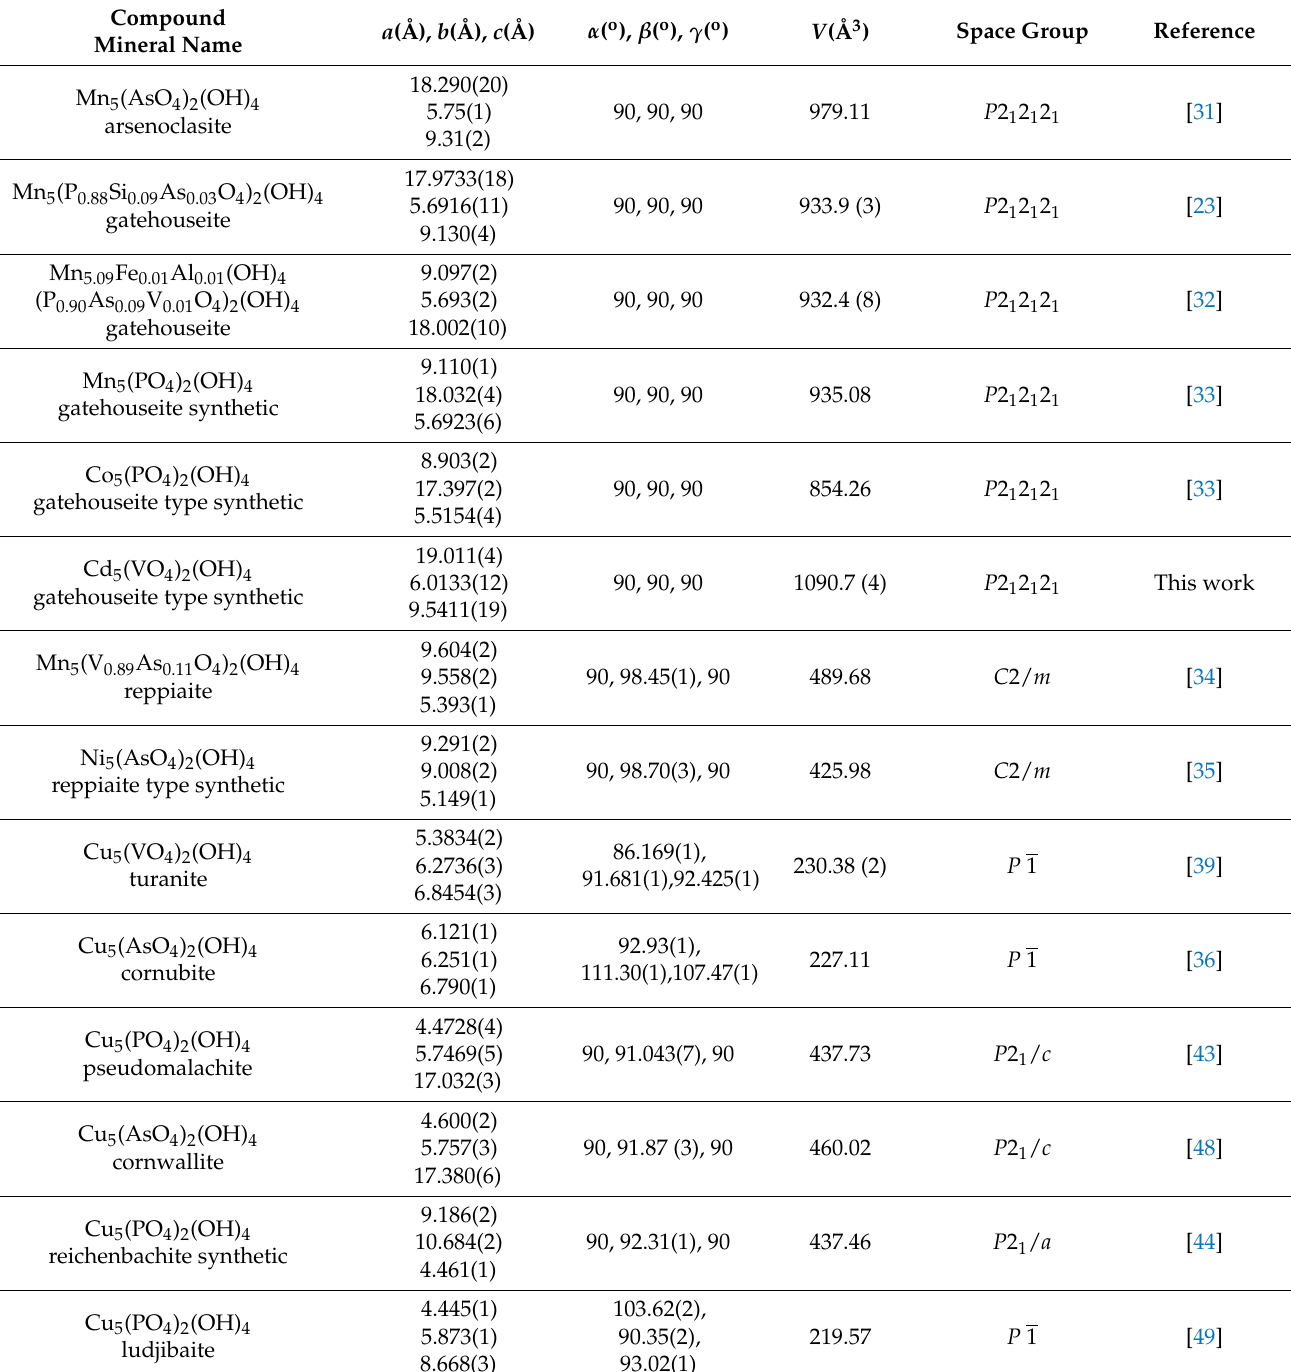
Table 6. Comparison of the unit cell parameters of analogous structures of M 5 ( X O 4 ) 2 (OH) 4